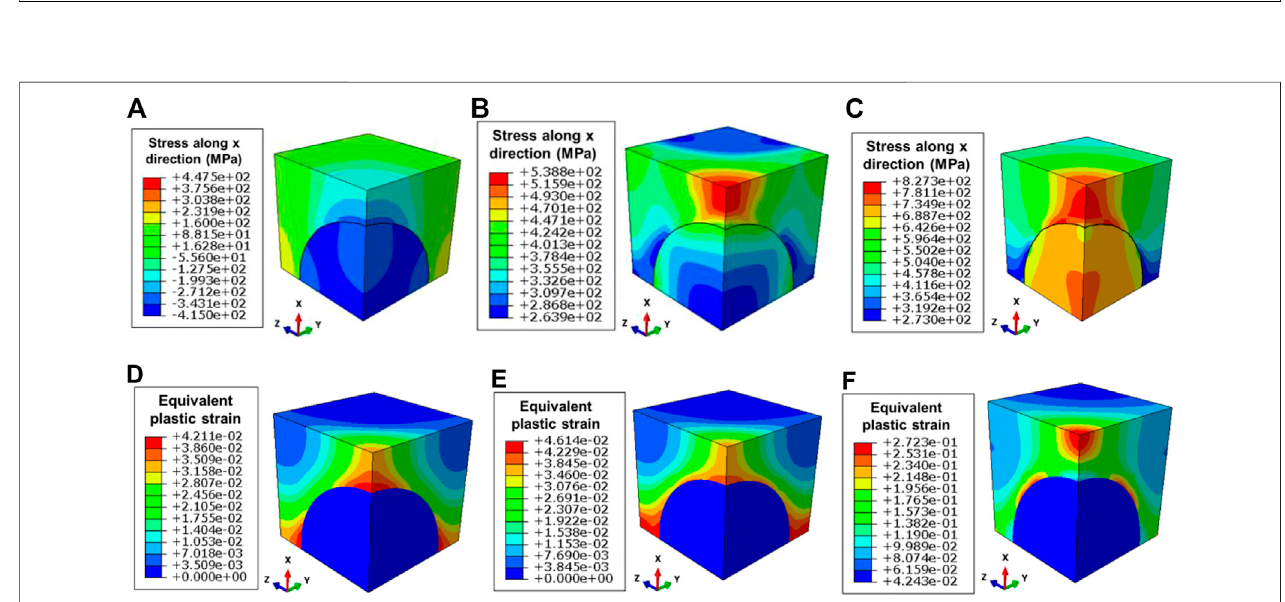
FIGURE5| Stressesalongthe x directionattheendofthe (A) irradiation, (B) quasi-elasticstage,and (C) thewholetensilestage,theequivalentplasticstrainsatthe end of the (D) irradiation, (E) quasi-elastic stage, and (F) whole tensile stage.